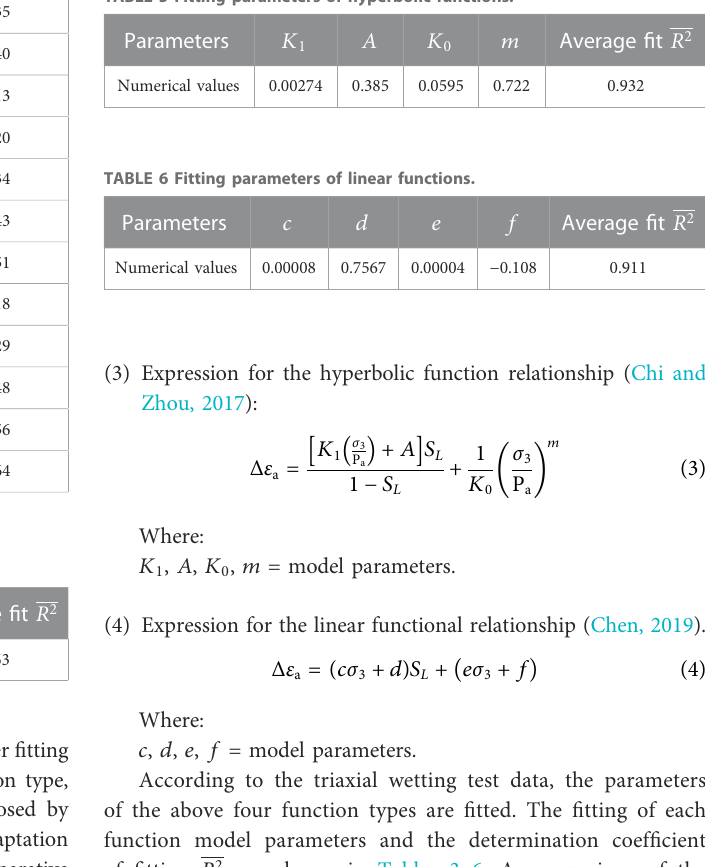
TABLE 5 Fitting parameters of hyperbolic functions.